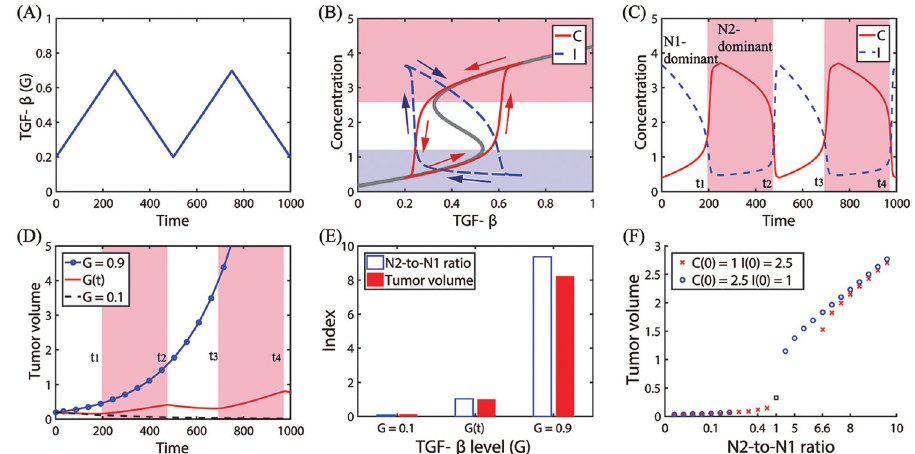
Fig 8. Effect of fluctuating TGF- β on tumor growth. (A) A time-dependent TGF- β level was assigned for a periodic supply of TGF- β in tumor microenvironment. (B) Trajectories of solutions (( G ( t ), C ( t )) and ( G ( t ), I ( t ))) in response to TGF- β in (A). The thick gray curve represents the upper and lower branches of steady states ( C − G hysteresis bifurcation loop in Fig 6). Red and blue arrows = solution flow direction of C and I , respectively. (C) Time courses of concentrations of C and I in response to periodic G input in (A). The N2-dominant P -regions were shaded in pink. t (D) Time courses of tumor volumes in response to a fixed ( G = 0.9 (blue circle); G = 0.1 (dashed)) and fluctuating TGF- β level. Fluctuating TGF- β levels induce transitions between N1- and N2-dominant phenotypes, leading to transient tumor growth at the transition times ( t 1 , t 2 , t 3 , t 4 ). (E) The N2-to-N1 ratio and tumor size for three TGF- β conditions in (D). (F) Positive correlations between the tumor volume and the N2-to-N1 ratio with two initial conditions ( C (0) = 1, I (0) = 2.5 in red asterisk; C (0) = 2.5, I (0) = 1 in blue circle). Initial conditions in (A-E): C (0) = 0.4, I (0) = 3.6, G (0) = 0.2, T (0) = 0.2. Other parameters are given in Table 2. periodic G input are shown in Fig 8C. The specific N1/N2 phenotypic transitions occur at time -status (white region in Fig 8C) t = t 1 , t 2 , t 3 , t 4 . For example, the initial N1-dominant P a switches to a N2-dominant P -mode (pink region in Fig 8C) in the tumor microenvironment t at time t = t due to increasing TGF- β levels. The TAN phenotypic ratio, described by C in 1 K þ g 1 I the second term of Eq (7), and N1 TAN immunity on tumor cells, described by δ IT in the third term of Eq (7), determine either promotion or suppression of tumor growth in the model. Fig 8D shows time courses of tumor volumes in response to either fixed or varying TGF- β : (i) high TGF- β ( G = 0.9, blue circle), (ii) low TGF- β ( G = 0.1, dashed), and (iii) fluctu- ating TGF- β levels given in Fig 8A. The high TGF- β level induces N2-dominant P -phase (Fig t 5C), therefore, leading to N2-mediated, faster tumor growth (blue circle). When G is low, the system induces the N1-dominant P microenvironment (Fig 5A), resulting in N1-mediated, a slower tumor growth (black dashed). On the other hand, fluctuating TGF- β induces alternat- ing transitions between P (white region) and P (pink region) phases at t = t , t , t , t (Fig 1 2 3 4 a t 8C), which induces slow (white band in Fig 8D) or fast (pink band in Fig 8D) tumor growth in and P -regions, respectively, and eventually leads to an intermediate tumor volume at final P a t time (Fig 8D). These results are in good agreement with experimental observations where N1 TANs significantly reduced the size of a tumor relative to N2 TANs [8]. The N2-to-N1 ratio (N21R) index and tumor volume corresponding to these three cases are shown in Fig 8E. An increase in the TGF- β level leads to an increase in the N2-to-N1 ratio, which in turn increase the tumor size. In Fig 8F, we investigate the correlation between N21R and the tumor size. The tumor volume and N21R were calculated from tumor and TAN populations in response to various TGF- β stimuli ( G = 0 − 0.9) with two different initial conditions: C (0) = 1, I (0) = 2.5 in red asterisk; C (0) = 2.5, I (0) = 1 in blue circle. The case of the fluctuating G ( t ) was marked in black square. As N21R is increased, the tumour volume is increased, leading to a positive